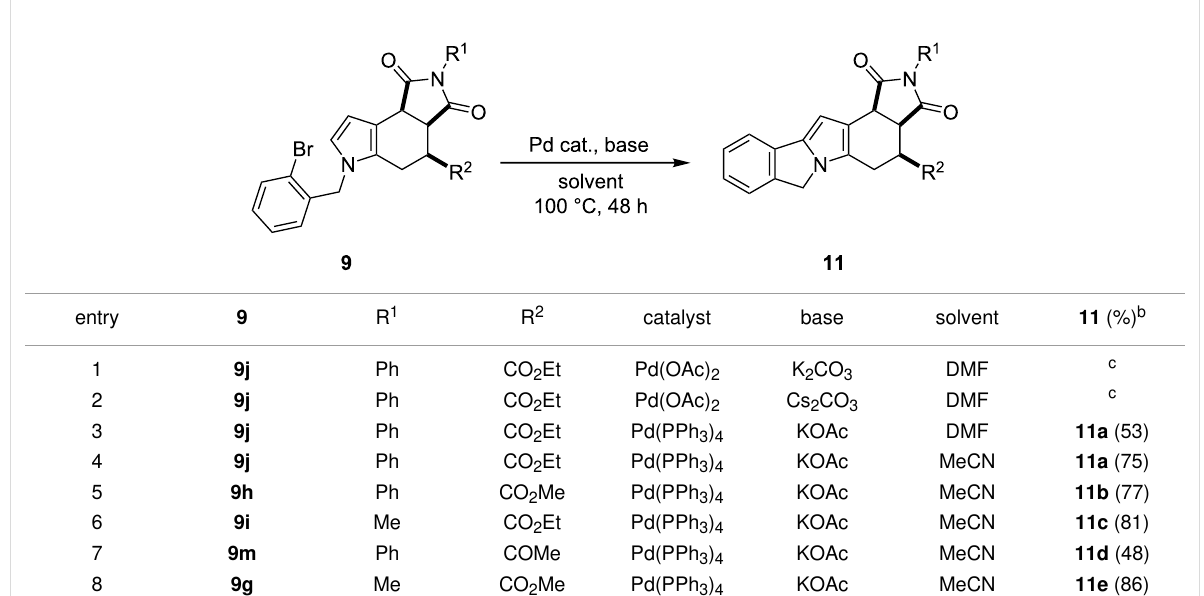
Table 3: Heck cross-coupling reactions of 9g – j and 9m for the preparation of pentacycles 11a – e . a